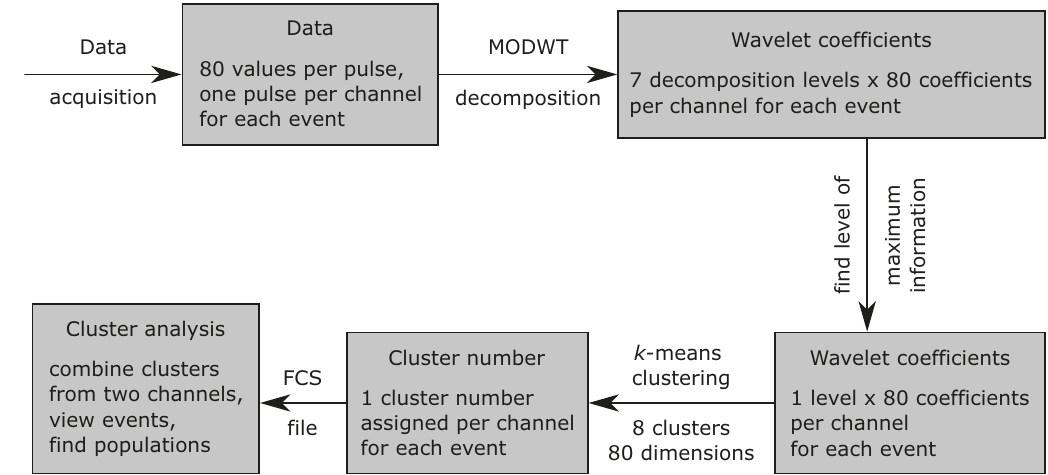
Fig. 8 Flow chart of the data analysis procedure. By maximum overlap discrete wavelet transform (MODWT), the relevant information of the PS is extracted. The k -means clustering reduces the data dimension from 80 data points down to one speci fi c